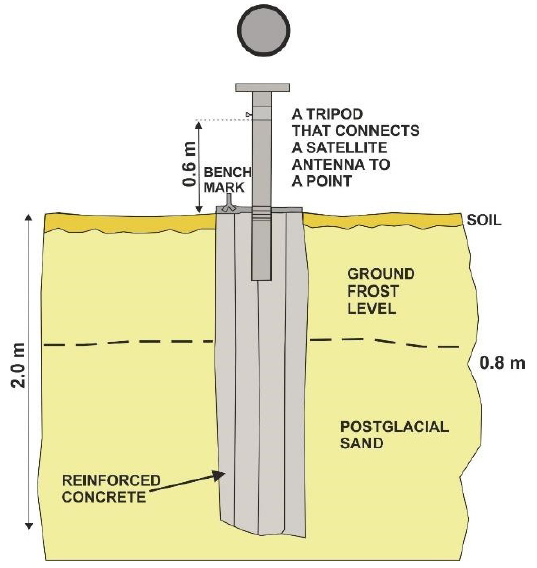
Figure 5. GNSS observation station mounting.